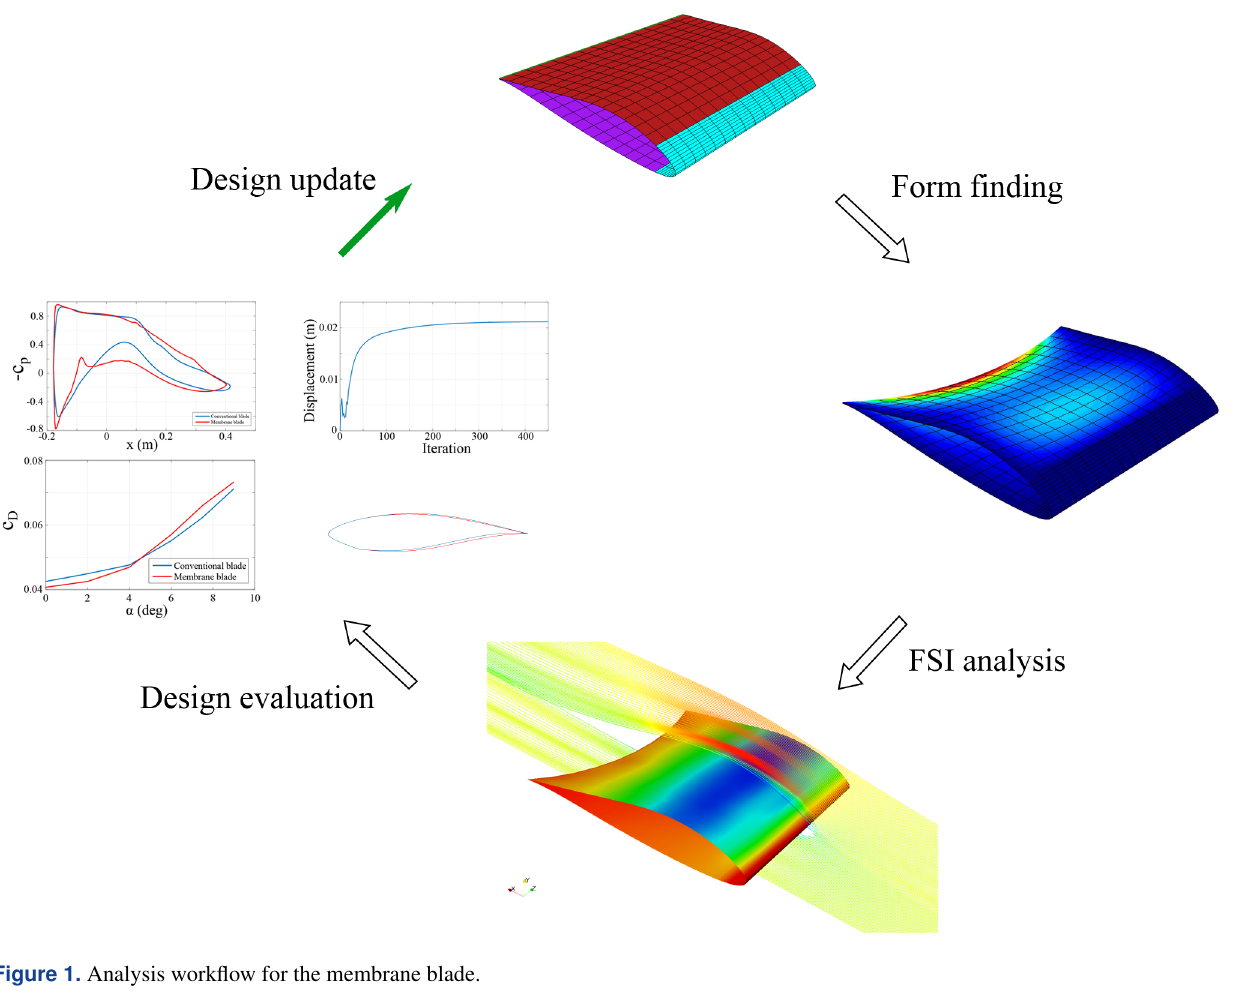
Figure 1. Analysis workflow for the membrane blade.